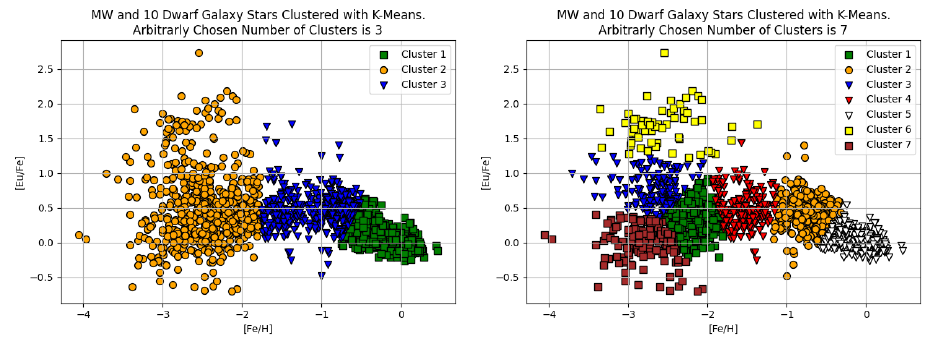
Figure 2. 3-cluster and 7-cluster analysis of [Eu / Fe] ratios as a function of [Fe / H], see